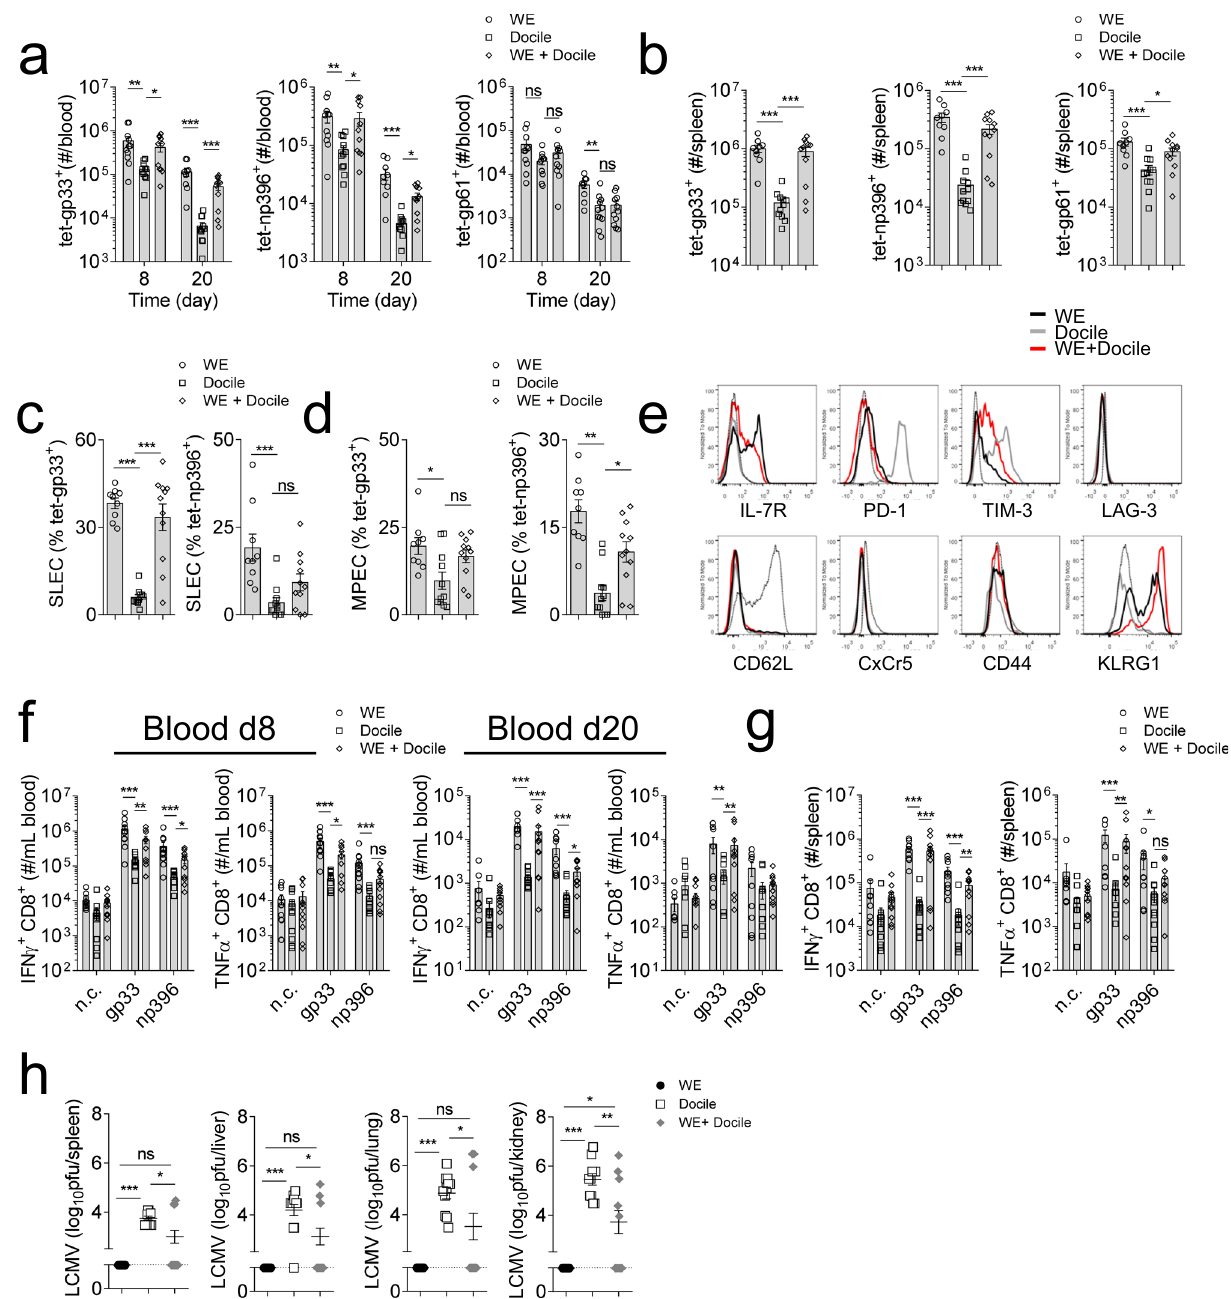
Fig. 1 Co-infection with LCMV-WE reverses the immunosuppressive effects of chronic LCMV-Docile viral infection. C57BL/6 mice were infected with LCMV-WE (WE) 2 × 10 4 pfu, LCMV-Docile (Docile) 2 × 10 4 pfu, or WE 2 × 10 4 pfu together with Docile 2 × 10 4 pfu (WE + Docile) for 20 days. a , b Mice were sacri fi ced at the indicated days post-infection and tet-gp33 + (CD8 + ), tet-np396 + (CD8 + ), and tet-gp61 + (CD4 + ) were determined in the a blood and b spleen tissue ( n = 9 – 11). Frequency of c short-lived effector cells (SLEC, KLRG1 + IL-7R − ) and d memory precursor cells (MEPC, KLRG1 − , IL-7R + ) were shown from splenic tet-gp33 + and tet-np396 + cells ( n = 9 – 11). e Representative surface molecule FACS blots are shown from splenic tet-gp33 + cells (A representative FACS blot of n = 9 – 11 is shown, dotted line represents surface molecule expression of CD19 + cells from WE infected hosts). f , g Mice were sacri fi ced at the indicated time post-infection and f blood cells and g single cell suspended splenocytes were re-stimulated with LCMV-speci fi c CD8 + T cell epitopes as indicated or left untreated (negative control: n.c.) followed by staining for IFN- γ and TNF- α ( n = 9 – 11). h at 20 days post-infection, virus titers were determined in the spleen, liver, lung, and kidney tissue ( n = 9 – 11). (Error bars show SEM, * p < 0.05, ** p < 0.01, *** p < 0.001, and ns indicates statistically not signi fi cant between the indicated